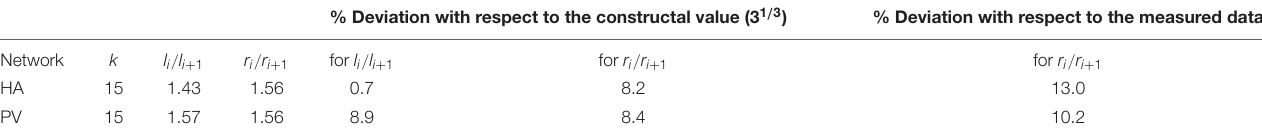
TABLE 2 | Construction parameters of the networks. % Deviation with respect to the constructal value (3 1 / 3 ) % Deviation with respect to the measured data